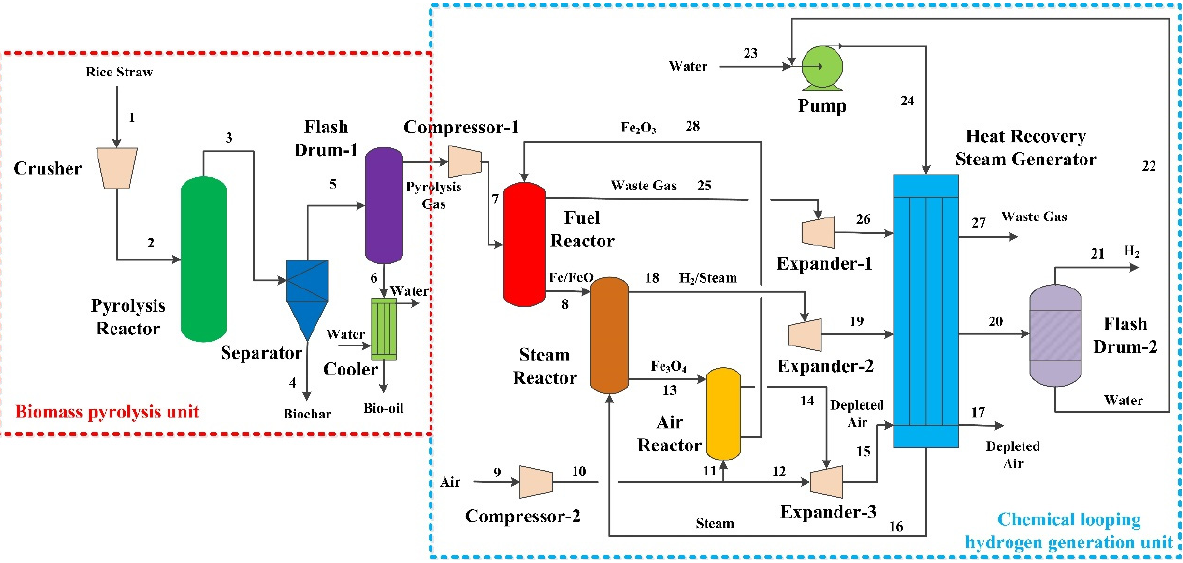
Figure 7. Flowsheet of the process for hydrogen, biochar and bio-oil coproduction by biomass py- rolysis integrated with chemical looping hydrogen generation.